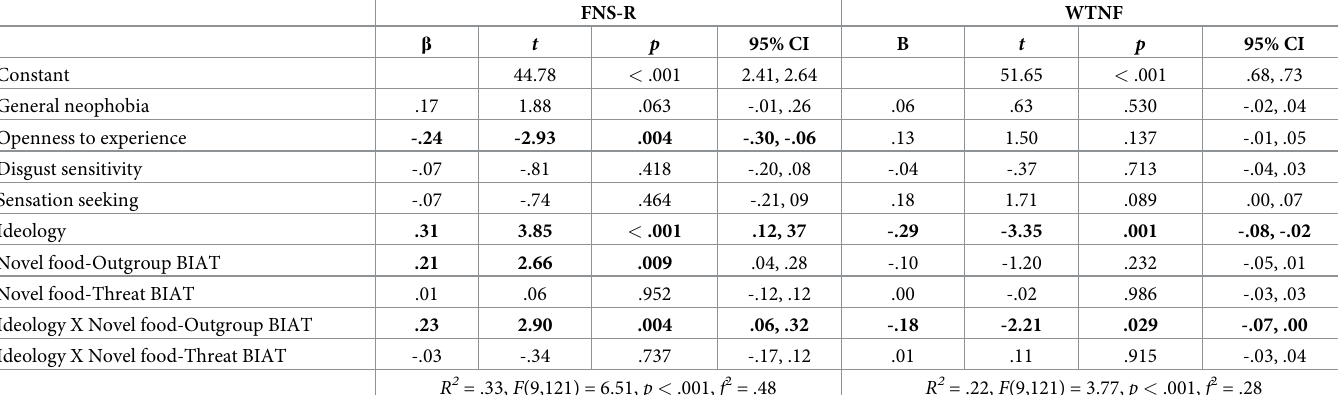
Table 4. Results of linear regression on participants’ food neophobia (both FNS-R and WTNF scores) predicted by covariates and socio-political ideology moder- ated by implicit associations between novel food and both foreigner outgroups and threat (Study 2).